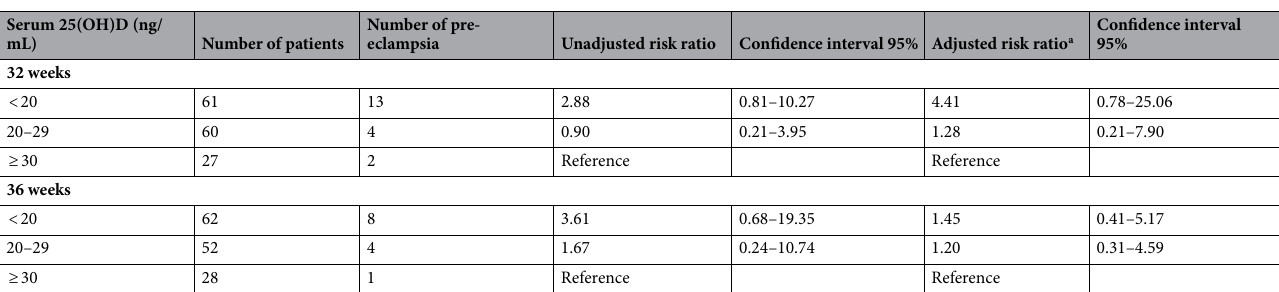
Table 3. Maternal vitamin D status at 32–36 weeks’ gestation and risk of pre-eclampsia in women at high risk. a Multivariate analysis adjusted for lupus, diabetes and personal history of PMC, at each concentration of serum